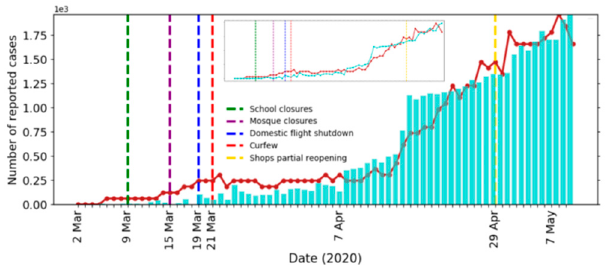
Figure 3. Actual (bar) and simulated (line) number of recorded cases per day. The inset shows the scaled number of new cases.